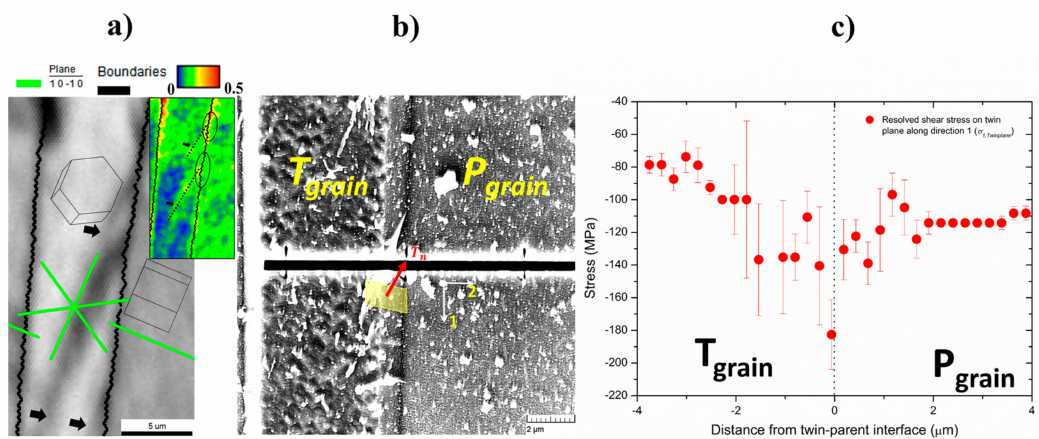
(cid:0) (cid:1) Figure 5. ( a ) Image quality map showing instances of 1010 prismatic slip bands interacting with twin parent interface; inset image shows corresponding local misorientation gradient along the identified slip trace; ( b ) SEM image of decorated twin-parent interface from Figure 4a; the twin boundary plane orientation is shown in yellow with twin plane normal T n . Slit coordinate system labelled by directions ‘1’ and ‘2’; ( c ) corresponding measured resolved shear stress component ( σ 1, Twinplane ) along line